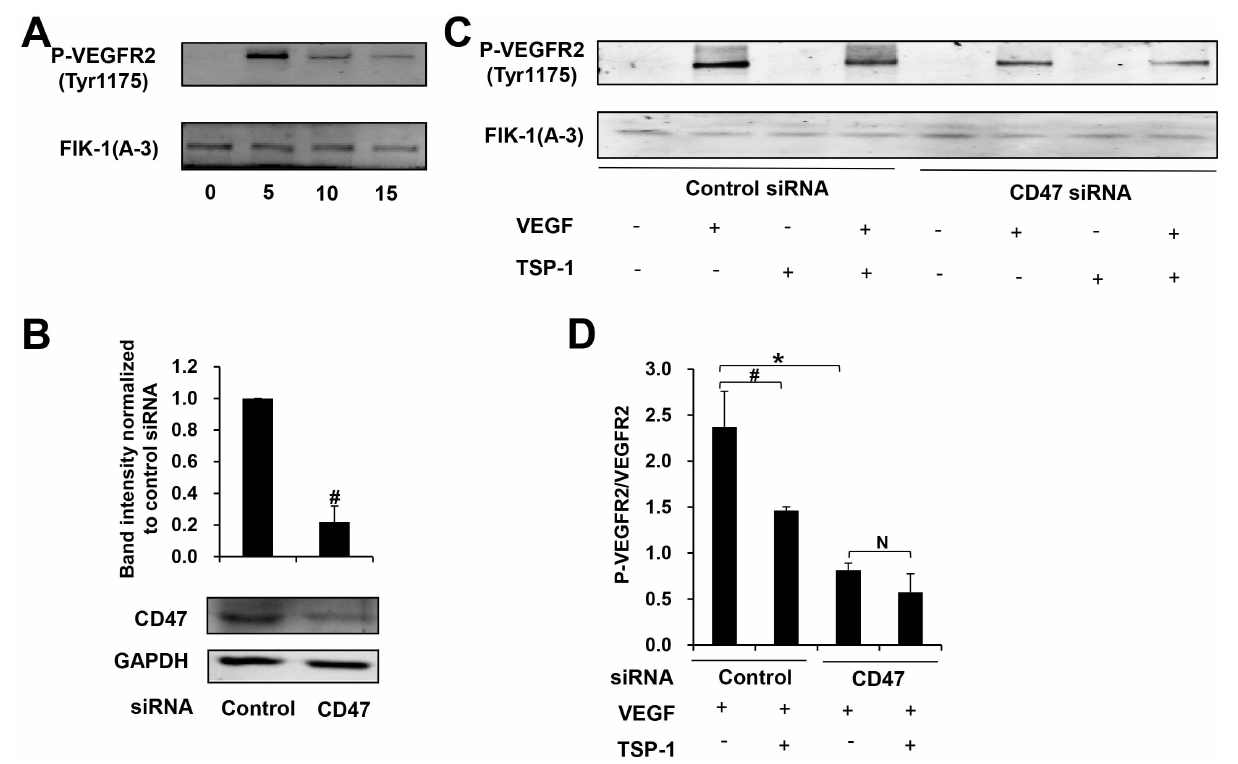
Figure 6. TSP-1 inhibits VEGF induced VEGFR2 phosphorylation through CD47. (A) Late EPCs were treated with VEGF (25 ng/ml) for 0, 5, 10, 15 min respectively. Total protein was extracted and the expression of FLK-1, phospho-VEGFR2 (Tyr1175) was determined by Western blot. (B)Seventy-two hrs after transfection of CD47-specific siRNA or control siRNA, the expression of CD47 in late EPCs was determined by western blotting analysis in three independent experiments ( # p , 0.05 versus control siRNA). (C)Seventy-two hrs after transfection of CD47-specific siRNA or control siRNA, late EPCs were treated with TSP-1(2 m g/ml) for 30 min and then VEGF(25 ng/ml) for 5 min. Total protein was extracted and the expression of FLK-1, phospho-VEGFR2 (Tyr1175) was determined by Western blot analysis. (D) Quantification of VEGFR2 phosphorylation normalized to VEGFR2 in three independent experiments( # p , 0.05 versus control siRNA, *p , 0.01 versus control siRNA).